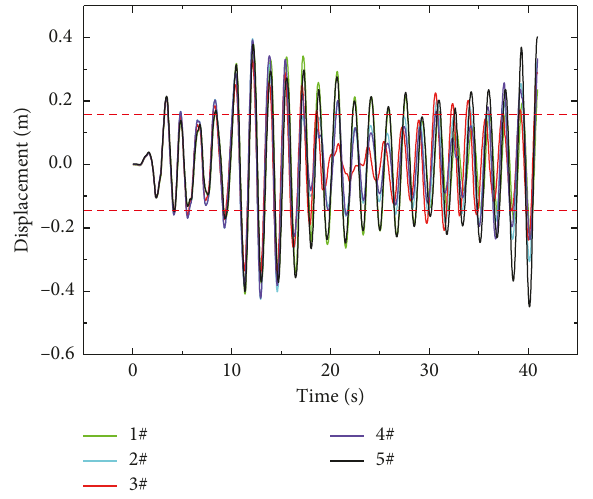
Figure 7: Time history of